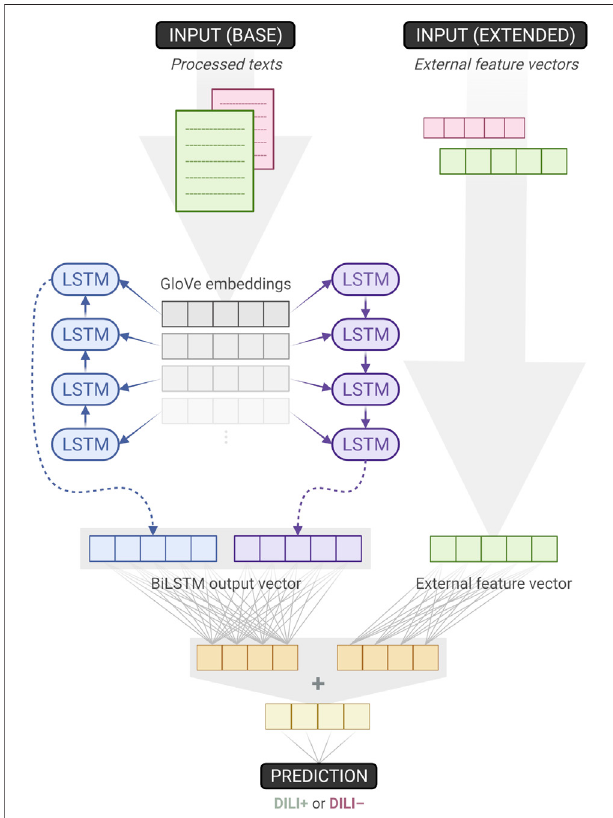
FIGURE 1 | Overview of the baseline and extended classi fi ers. The former accepts texts as its single input, while the latter augments its baseline counterpart by also utilising external feature vectors. When training the baselinemodel,weightsdownstreamthe “ baseinput ”– ontheleftsideof the fi gure – are learnt. Since the extended model is built on top of the baseline, those weights can be transferred and frozen, effectively remaining unchanged during training. As a result, for the extended model, only one dense layer ’ s weights have to be trained (Created with BioRender.com).